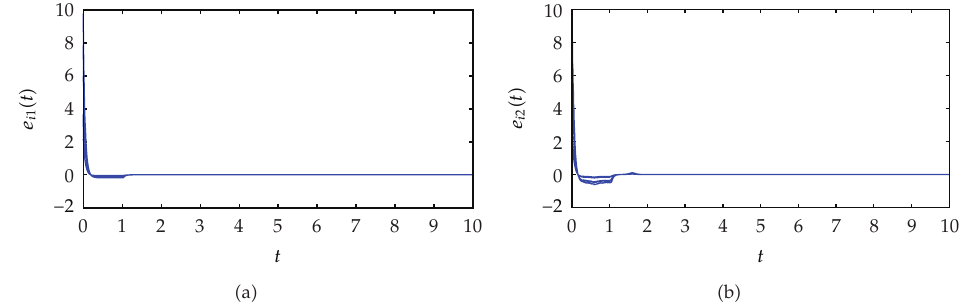
Figure 2: The time evolution of e i 1 and e i 2 (cid:3) i (cid:8) 1 , 2 ,..., 5 (cid:4) in system (cid:3) 4.3 (cid:4) under pinning control.